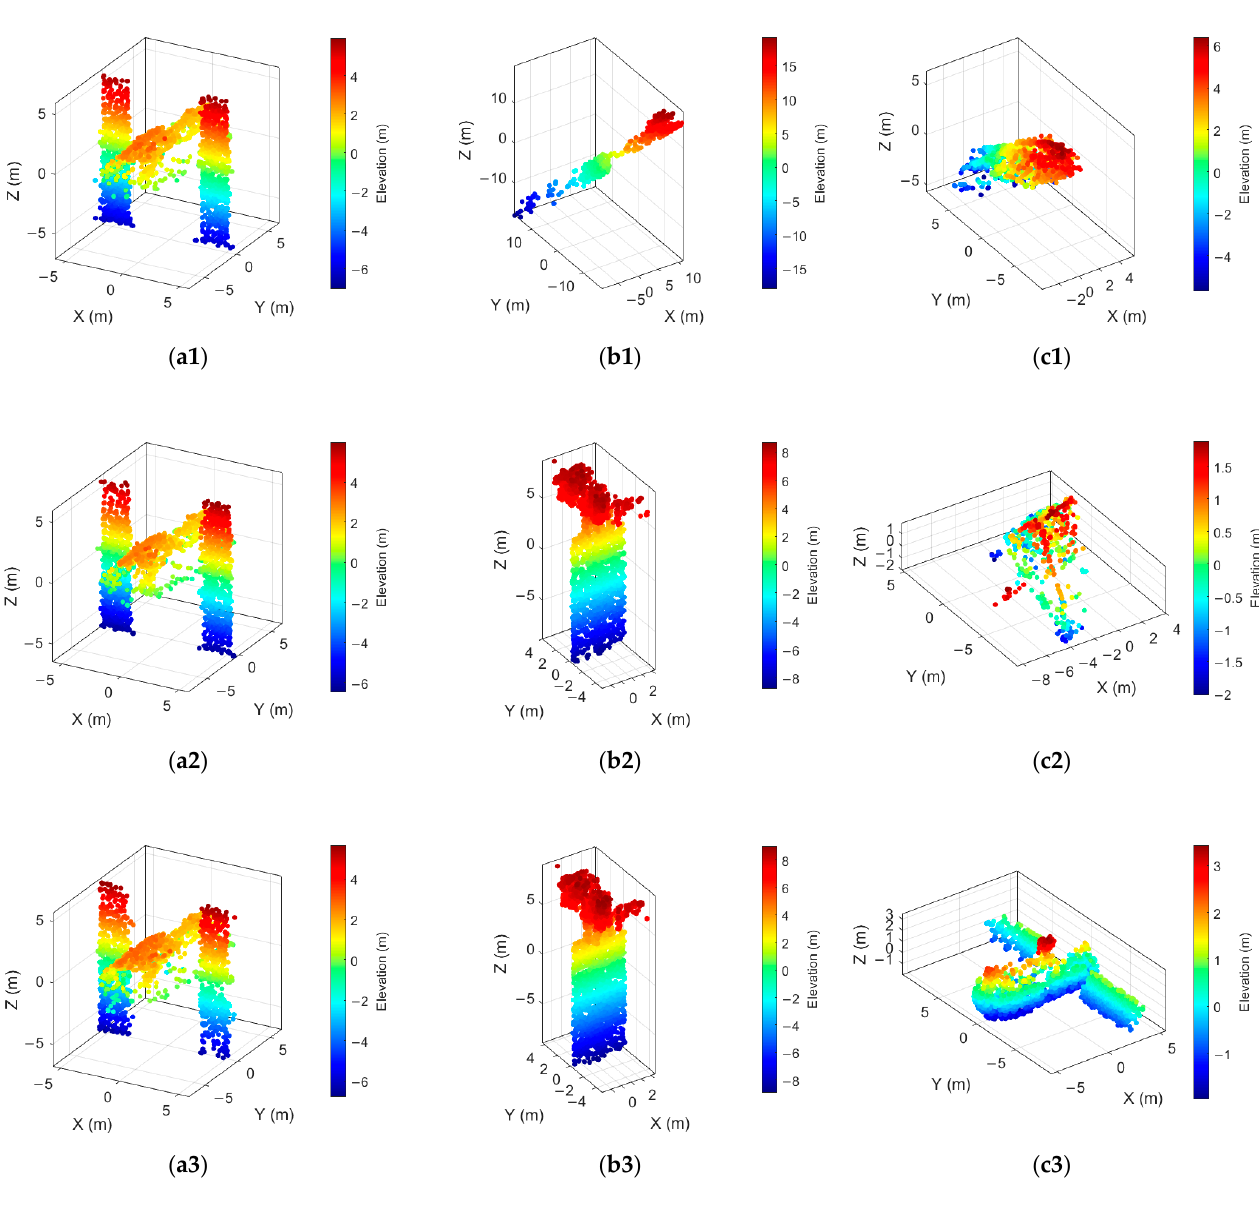
Figure 8. The reconstructed 3D point clouds of HST, Aqua, and Tiangong-1 via ( a1 – c1 ) the method